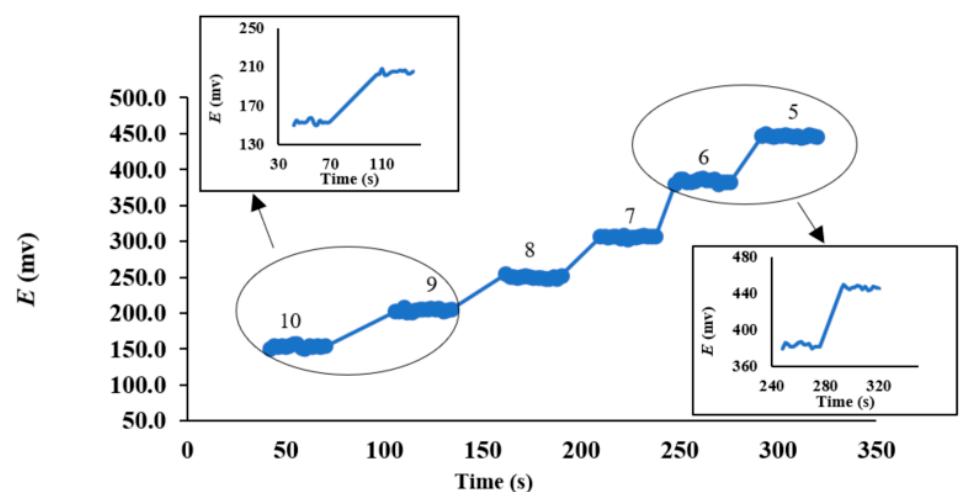
Figure 3. Dynamic response time of copper sensor at different concentration of Cu 2+ : The numbers denote the concentration (mol · L − 1 ) of Cu 2+ in pM ( − log [Cu 2+ ]) format. Experimental conditions: KNO 3 0.1 mol · L − 1 in HAc-NaAc buffer 0.1 mol · L − 1 pH 5.0, room temperature, 6B pencil as a reference electrode and CPE (72 wt % of graphite powder and 28 wt % of Nujol oil) as an indicator electrode. For each concentration, a separate sensor was used.